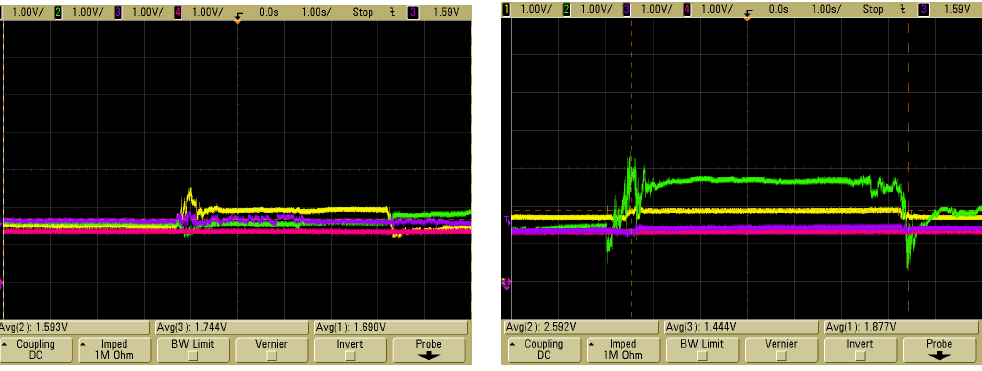
Figure 25. Response of strip 1 and 2.